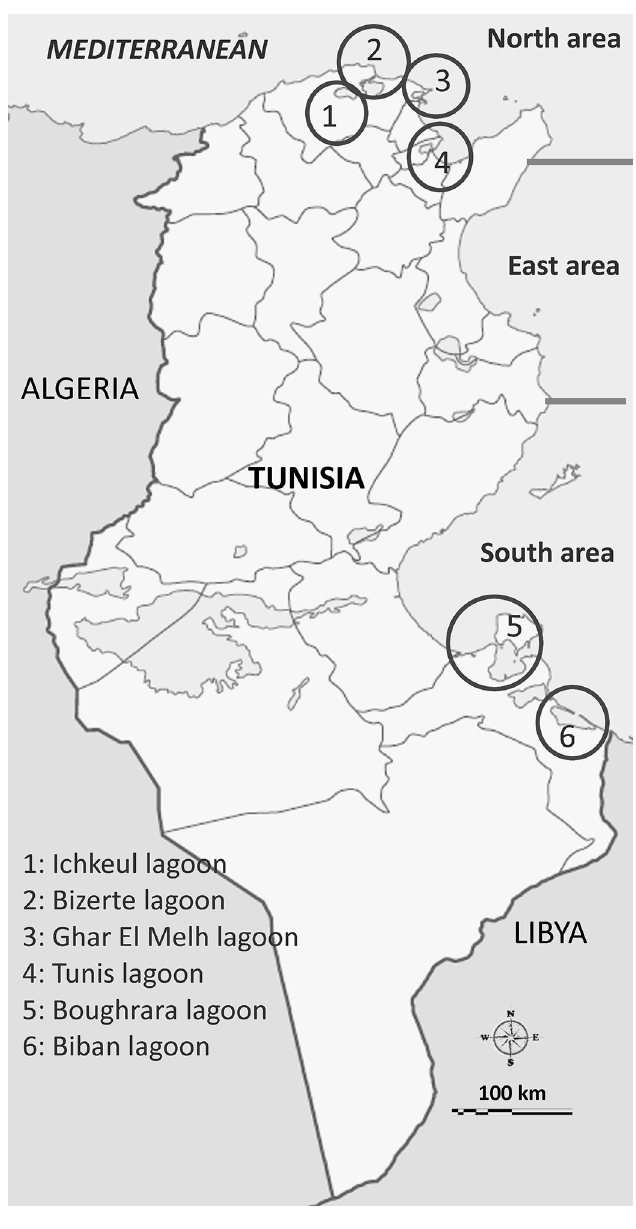
Fig. 1. Coastal areas and lagoons of